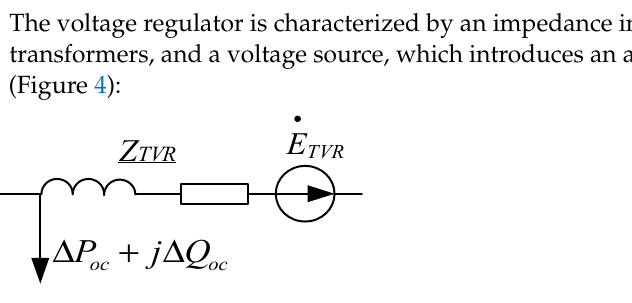
Figure 3. Equivalent circuit of a two-winding transformer.